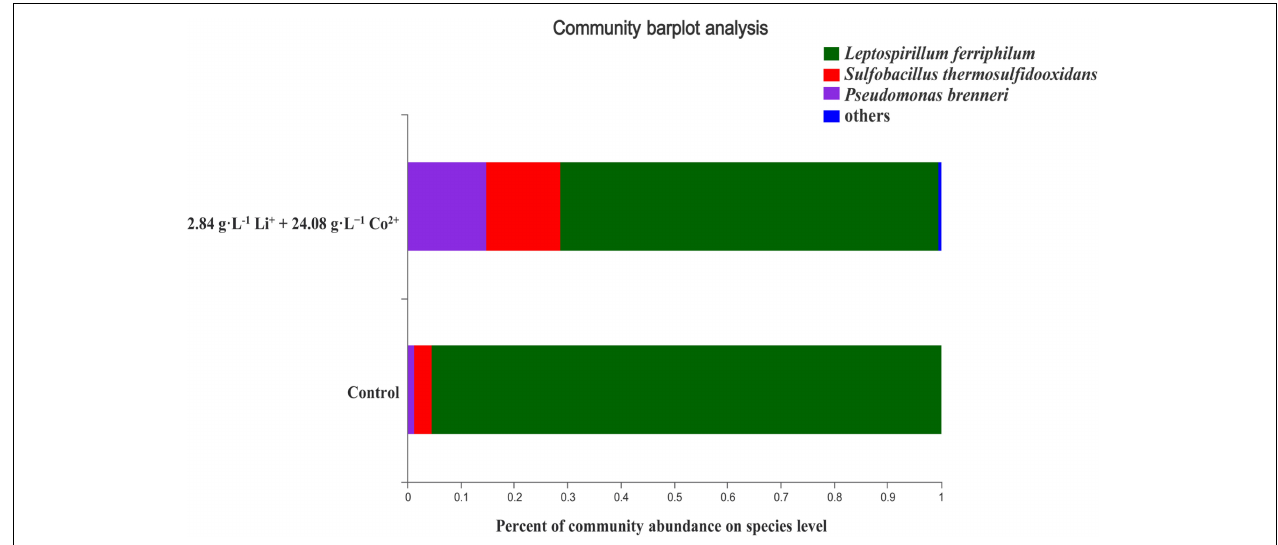
FIGURE 1 | The structural composition of AMC under the control and test